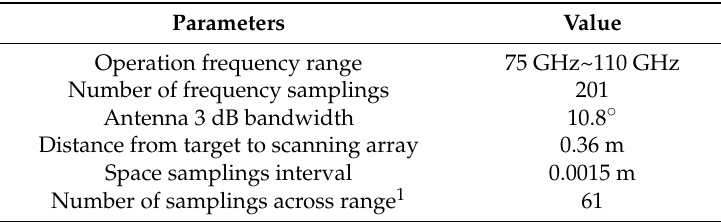
Table 3. The parameters used in the experiment.